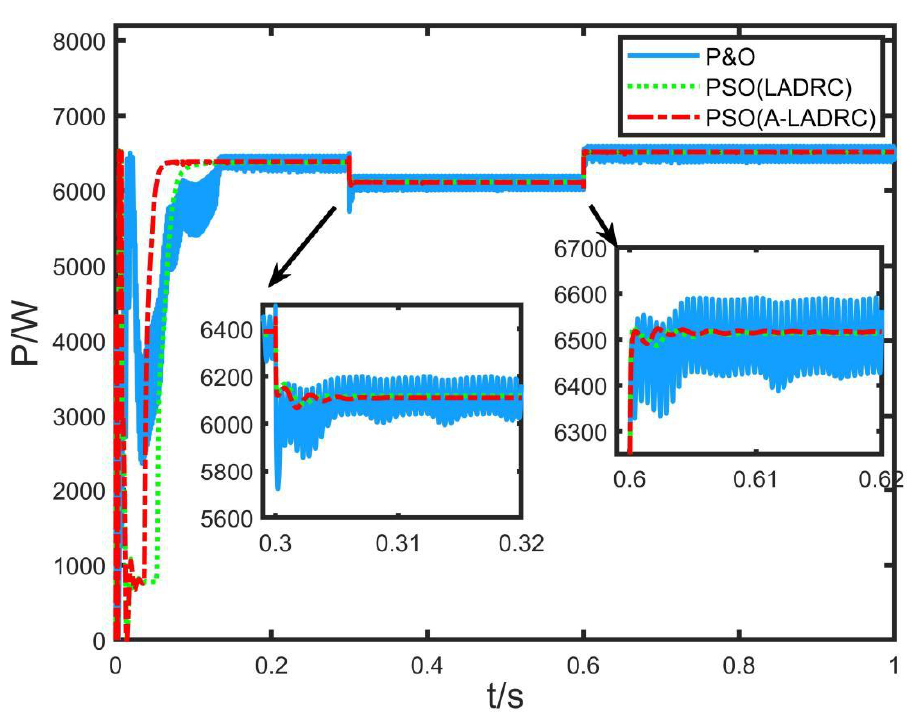
Figure 10. Output power of photovoltaic array when temperature is changed.